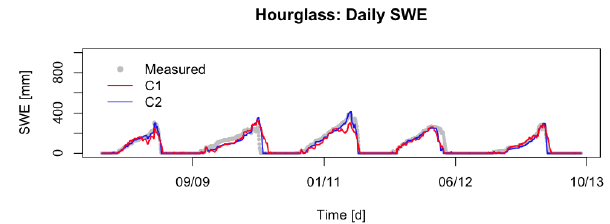
Fig. 6. Calibration and evaluation model results for the station- Figure 6. Calibration and evaluation model results for station- specific calibration test at the Hourglass station: the gray dots rep- specificcalibrationtestinHourglassstation:thegraydotsrepresent themeasuredSWE,thesolidredlinerepresentsthemodelC1(clas- resent the measured SWE, the solid red line represents the model sicaltemperature-indexmodel)andthebluesolidlinerepresentsthe C1 (classical temperature index model) and the blue solid line rep- modelC2(CazorziandDallaFontana). resents the model C2 (Cazorzi and Dalla Fontana).